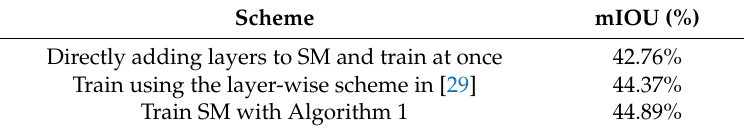
Table 3. Mean pixel IOU (mIOU) of the Segmentation Module (SM) trained with different schemes. Scheme mIOU (%) Directly adding layers to SM and train at once 42.76% Train using the layer-wise scheme in [29] 44.37% Train SM with Algorithm 1